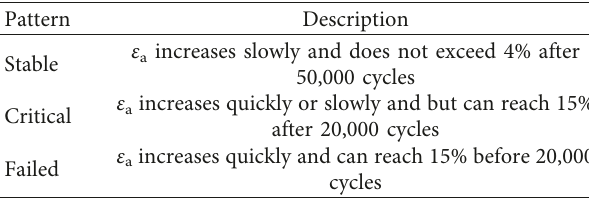
Figure 8: Effects of increasing σ 3 on the safety factor against shear failure. Table 5: Method for classifying specimen patterns. Pattern